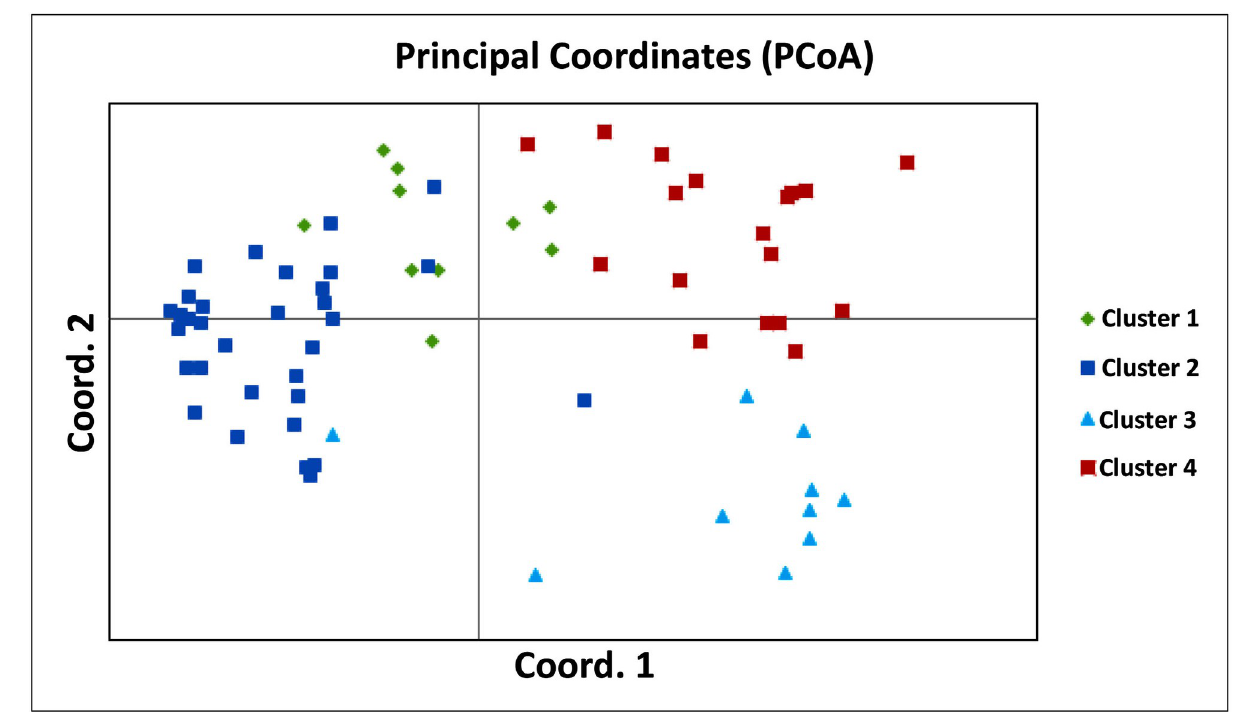
Fig 3. Principal coordinate analysis of four cluster of 70 cowpea